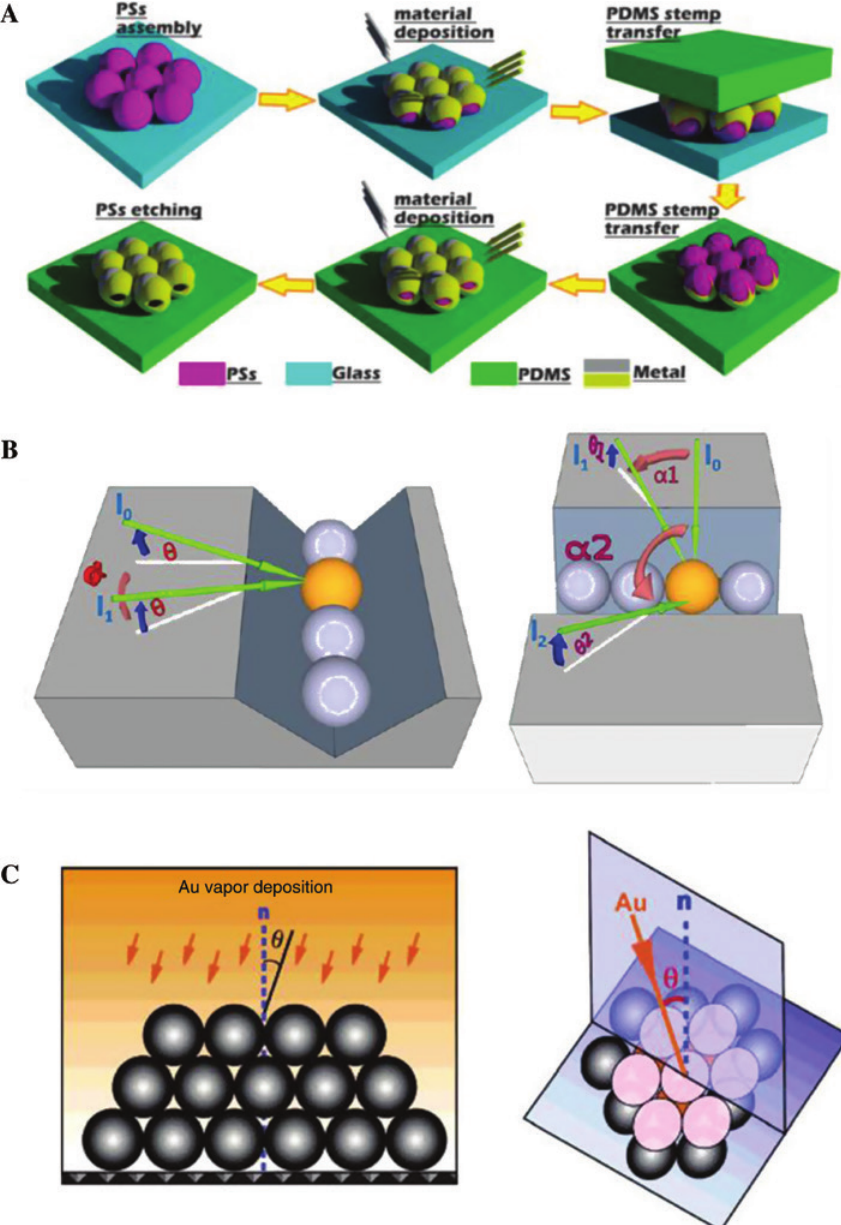
Figure 8: Patchy particles fabricated by modifying the monolayers. (A) Schematic of the fabricating process of two-pole patchy particles [100]. (B) Schematic of metal vapor flow in template-assisted patchy particle fabrication using the glancing angle deposition method with a template at various angles [101]. (C) Schematic depictions of